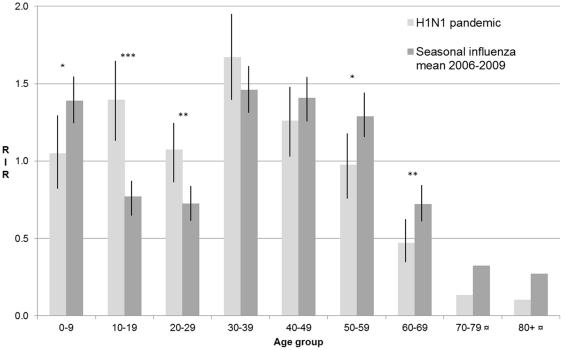
RIR diagrams for pandemic and seasonal influenza outbreaks in Östergötland county 2006–2010.The RIR diagrams (95% Confidence Intervals) represent the A pH1N1 outbreak in 2009 and mean values for the seasonal outbreaks 2006–2010, respectively. * p<0.05 **p<0.01 ***p<0.001 ¤ Too few observations to allow statistical analysis.